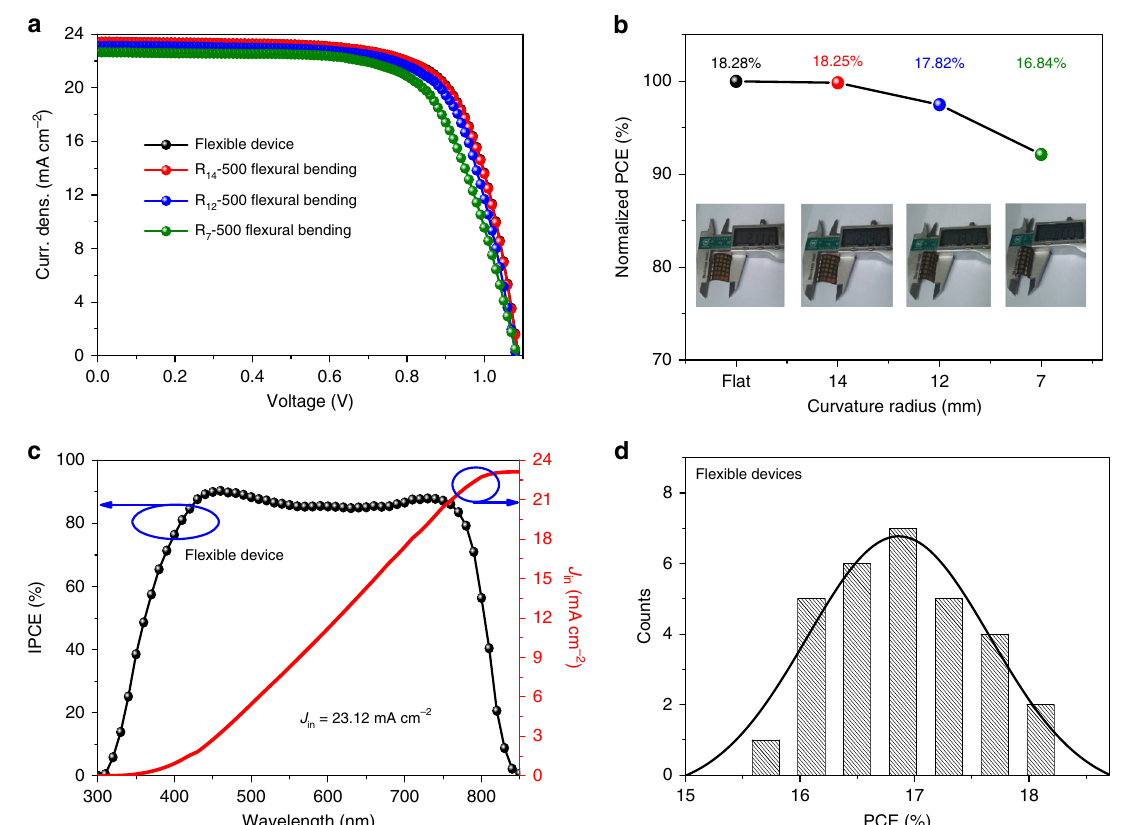
Fig. 7 The performance of fl exible PSCs based on E-SnO 2 ETLs. a J – V curves of the fl exible devices and after fl exing at curvature radii of 14 mm, 12 mm, and 7 mm for 500 cycles, respectively. b The normalized PCE measured after fl exing at different curvature radii. c IPCE curves of the fl exible device. d The PCE distribution histogram of the fl exible